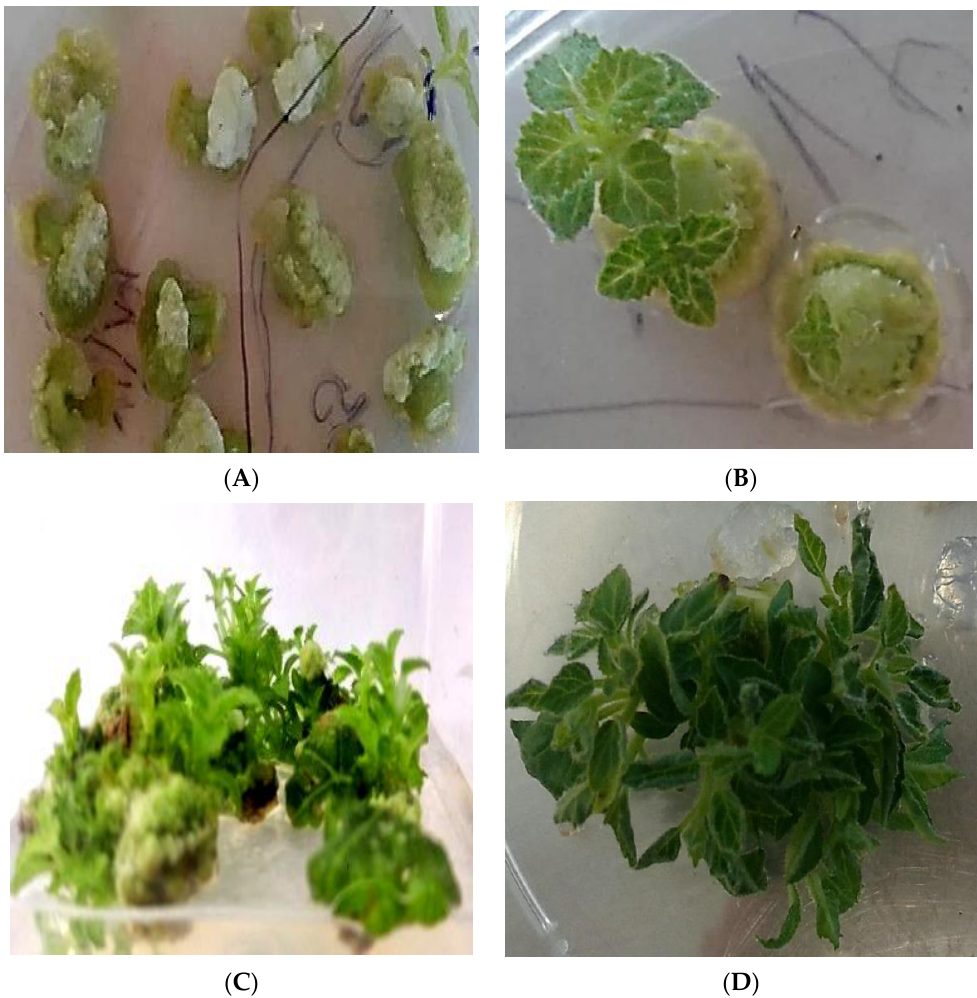
Figure 3. Indirect and direct plant regeneration from different types of explants on MS2 medium: internodes and petals indirectly, through the callus formation ( A ) and directly, without calli formation, on nodal explants ( B ); plant regeneration from leaves ( C ) and apical shoot tips ( D ) through the callus formation.